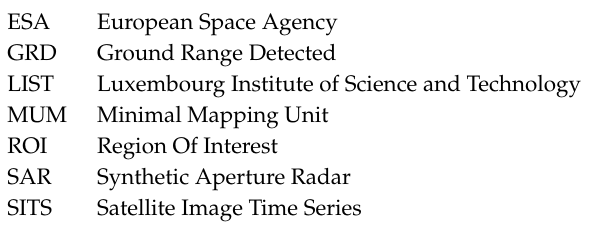
Figure S1: Comparison for Mozambique of Otsu tiled thresholding and Unisat flood map on 14 March 2019 (Timestep 2), Figure S2: Comparison for Mozambique of Otsu tiled thresholding and Unisat flood map on 20 March 2019 (Timestep 3), Figure S3: Comparison for Mozambique of Otsu tiled thresholding and Unisat flood map on 26 March 2019 (Timestep 4), Figure S4: Comparison for Mozambique of Otsu tiled thresholding and LIST flood map on 20 March 2019 (Timestep 3), Figure S5: Comparison for India of Otsu tiled thresholding and Sentinel Asia flood map on 30 September 2019 (Timestep 3), Video S1: Mozambique pre-processing results, Video S2: Mozambique flood delineation, Video S3: Mozambique variation, Video S4: India pre-processing results, Video S5: India flood delineation, Video S6: India variation, Figure S6: Additional temporal profile and variation evolution for water body in India (graph 10501), Video S7: Spatial evolution of water body in India (graph 10501), Figure S7: Unified flood map Mozambique